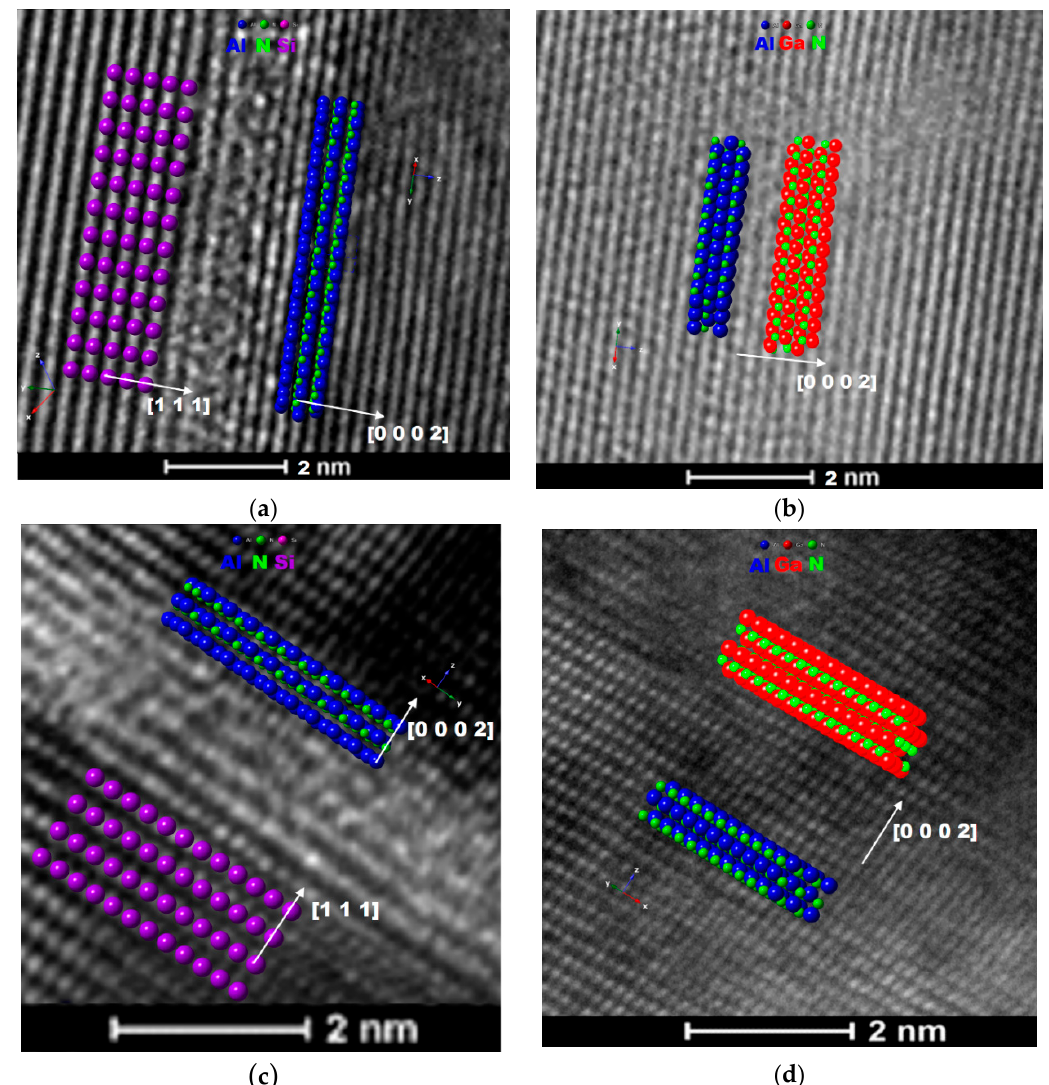
Figure 2. HR-TEM micrographs with display of simulated crystal lattices near the interface between Si substrate and AlN buffer layer in ( a ) GaN300/Si, ( c ) GaN700/Si and between AlN buffer layer and GaN film for ( b ) GaN300/Si, ( d ) GaN700/Si.